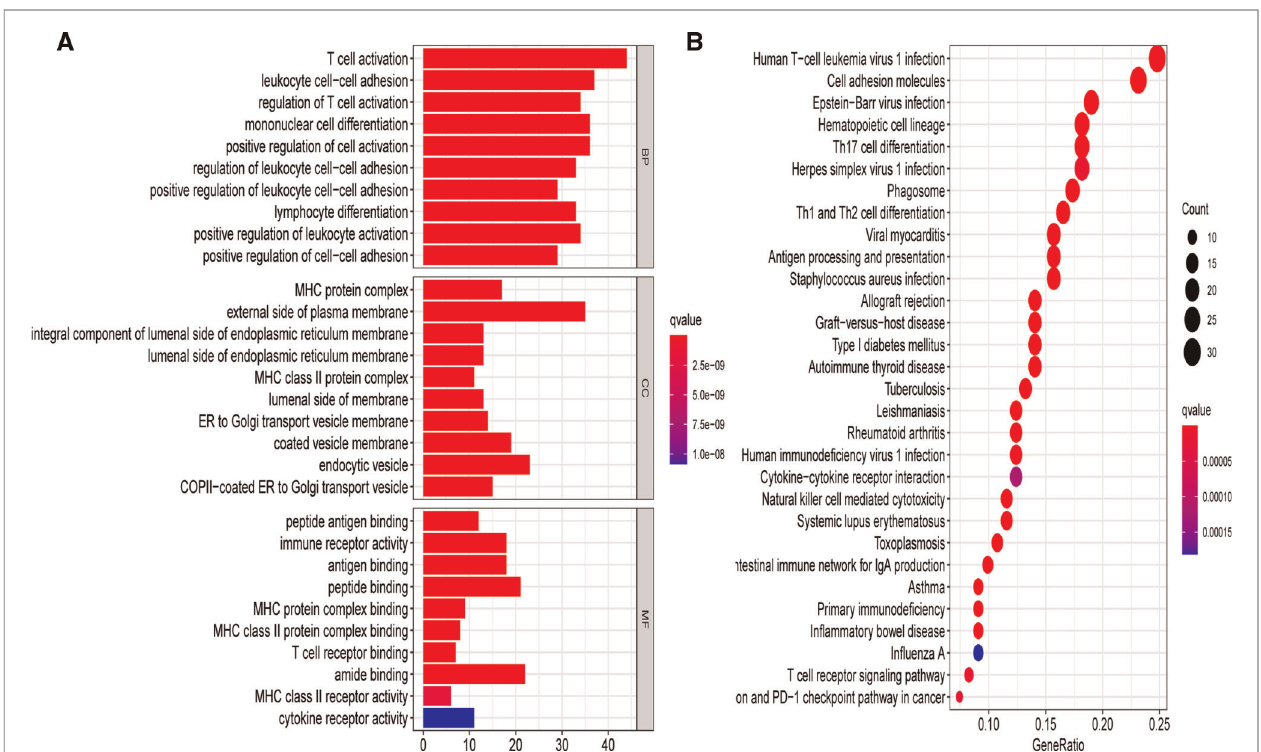
FIGURE 10 | Gene Ontology (GO) and Kyoto Encyclopedia of Genes and Genomes (KEGG) analyses on the basis of DEGs between different risk groups in the TCGA-BRCA cohort. ( A ) Bar plot graph for signi fi cant GO enrichment. ( B ) Bubble graph for signi fi cant KEGG